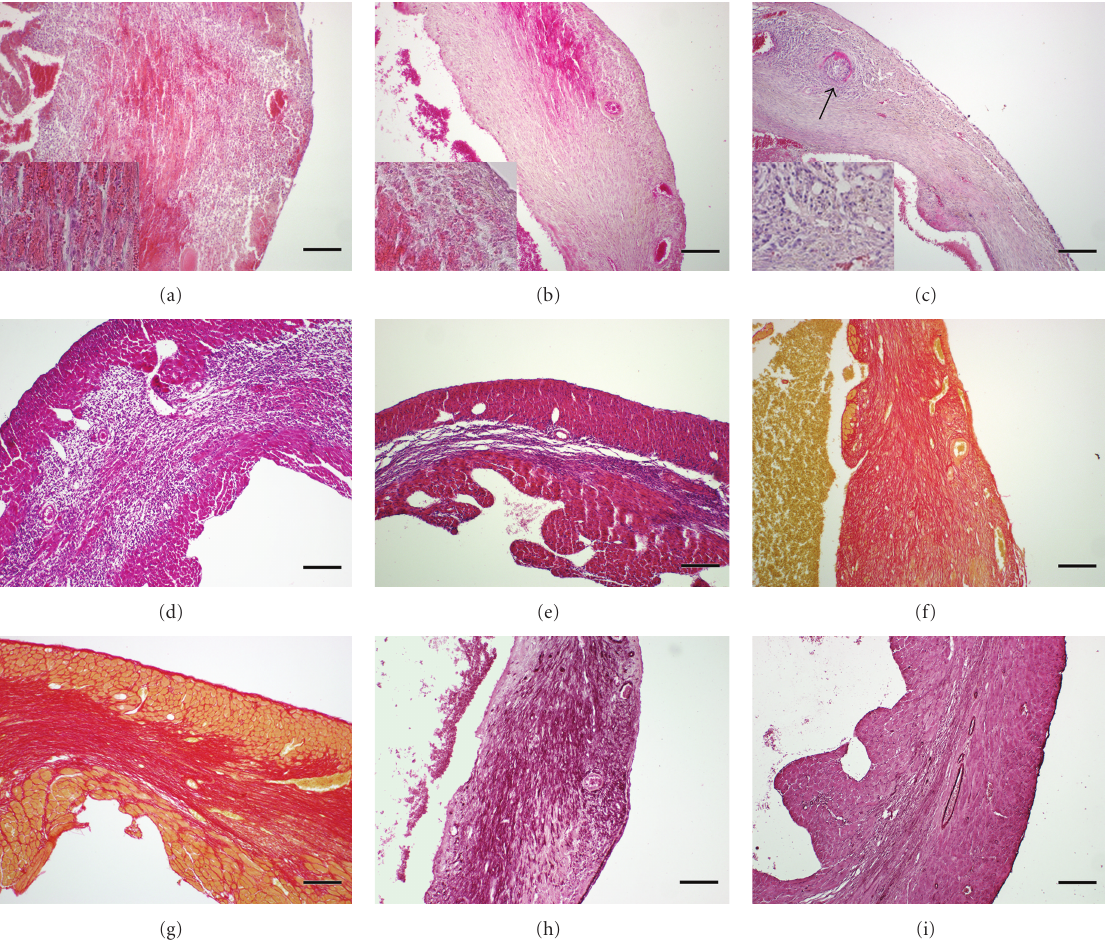
Figure 1: Comparison of myocardial histopathology between cryoinfarction and reperfused infarction. Hematoxylin-eosin staining of left ventricular lateral wall in cryoinfarction after (a) 3 days an increased cellular infiltration with extensive cardiomyocyte debris, with (b) formation of granulation tissue after 7 days, and (c) an almost compacted scar formation after 14 days postinjury with permanent occlusion of a large coronary vessel (arrow). In parts (a)-(c), a higher magnification (400x) insert shows cellular and matrix content in detail. In contrast, (d) reperfused myocardial infarction shows granulation tissue formation after 3 days and (e) a compacted, nontransmural scar formation after 7 days reperfusion. Picrosirius red staining of (f) cryoinfarction after 7 days reveals loose collagen fibers, while (g) reperfused infarction presents a compacted, collagen-rich scar. Alpha smooth muscle actin staining of myofibroblasts (black-stained cells) indicates (h) active interstitial remodeling 7 days after cryoinfarction whereas (i) reperfused infarction has only few positive cells in the scar (eosin counterstaining). Scale bar: 150 μ